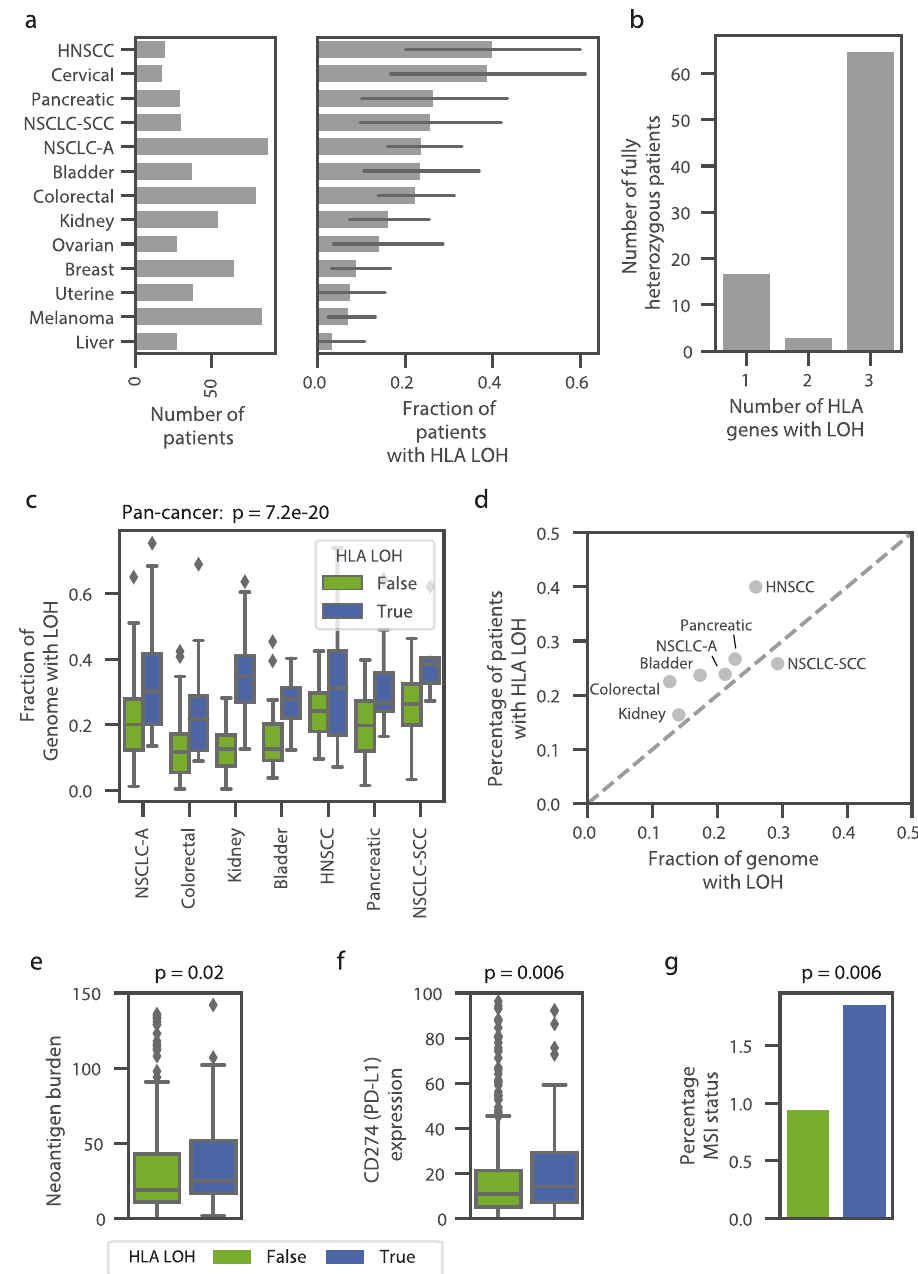
Fig. 5 Widespread impact of HLA LOH across tumor types. a Bar plots denoting the number of patients and the frequency of HLA LOH in each tumor type cohort. Only cohorts with at least 10 patients are shown (see source data for precise n of each cohort). 95% con fi dence intervals are shown in dark gray. b A bar plot showing the number of patients with 1, 2, or 3 genes impacted by HLA LOH. Only patients that are fully heterozygous across HLA-A , HLA-B , and HLA-C are shown. c Boxplots showing the distribution of the fraction of each genome impacted by LOH. Each tumor type is divided into patients with HLA LOH and without HLA LOH. Only tumor types with at least 10 patients impacted by HLA LOH are shown (with n = 88 for NSCLC-A; 80 for Colorectal; 31 for NSCLC-SCC; 55 for Kidney; 38 for Bladder; 30 for Pancreatic; 20 for HNSCC). The center of the box denotes the median value, the box denotes the quartiles and the whiskers denote the remainder of the distribution apart from outliers. Statistical analyses are performed with two-sided Mann – Whitney U tests and are Bonferroni corrected ( p = 7.2e − 20). d A scatter plot showing the relationship between the average fraction of the genome impacted by LOH and the frequency of HLA LOH in each tumor type. The gray dashed line denotes x = y . e and f Box plots denoting the average difference for patients without HLA LOH (green) and patients with HLA LOH (blue) for e neoantigen burden ( n = 468 patients) and f CD274 (PD-L1) expression ( n = 605 patients). The center of the box denotes the median value, the box denotes the quartiles and the whiskers denote the remainder of the distribution apart from outliers. Some outliers are excluded from the plot in order to focus on the majority of the distribution. Statistical signi fi cance was assessed using a two-sided Mann – Whitney U test. g Bar plot denoting the average difference for patients without HLA LOH (green) and patients with HLA LOH (blue) for percentage of microsatellite sites with instability ( n = 576 patients). Source data are provided with this paper. NSCLC-A non-small cell lung cancer adenocarcinoma, NSCLC-SCC non-small cell lung cancer squamous cell carcinoma, HNSCC head and neck squamous cell